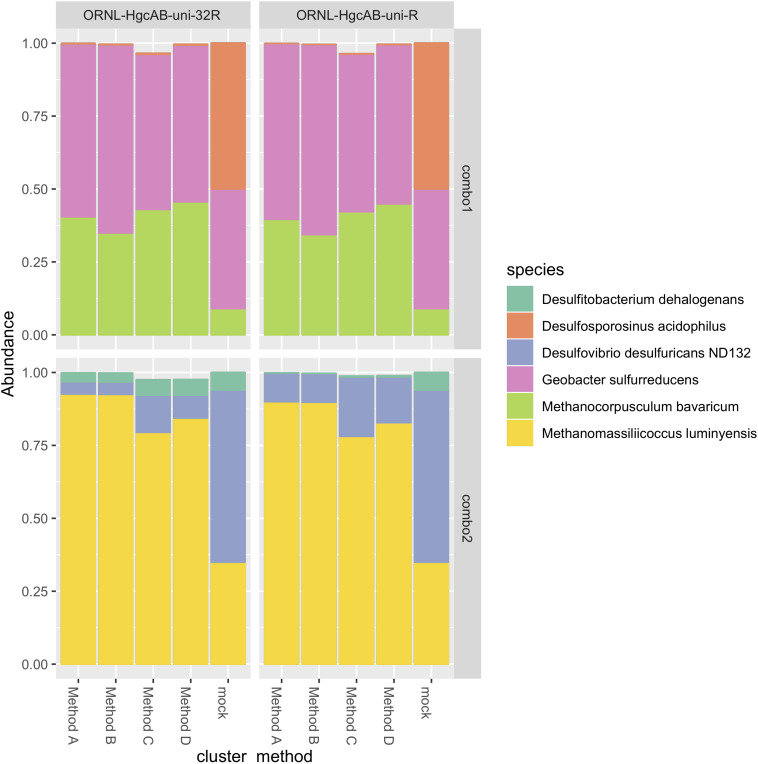
Comparison of expected and actual taxonomic composition of hgcA sequences in recovered mock community amplicon libraries. Top, mock community Combo1; bottom, mock community Combo2. Libraries were constructed using the newer less degenerate hgcAB reverse primer (left) or the Christensen 2016 reverse primer (right). Comparison of various clustering methods: Method A: cluster nucleotide sequences at 90% identity using VSEARCH; Method B: cluster peptide sequences at 90% identity, using USEARCH; Method C: clustering nucleotide sequences at 90% using cd-hit-est; Method D: chimeras removed prior to clustering nucleotide sequences at 90% using cd-hit-est.